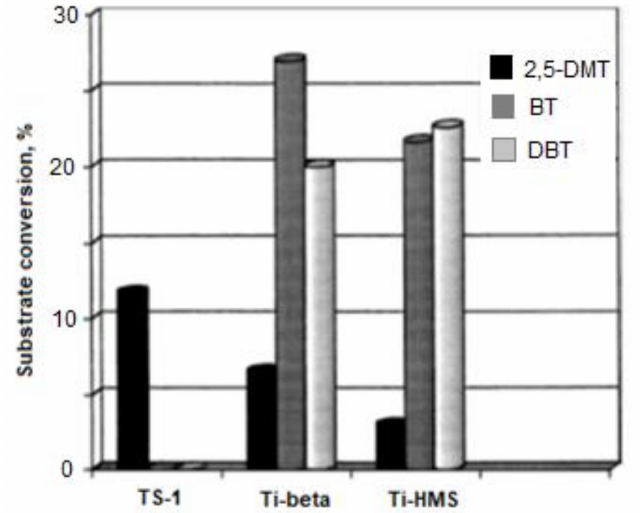
Figure 4. Influence of catalyst type on the conversion of thiophene derivatives in the oxidation with H 2 O 2 . Reprinted with permission from ref. [26]. Copyright 2001